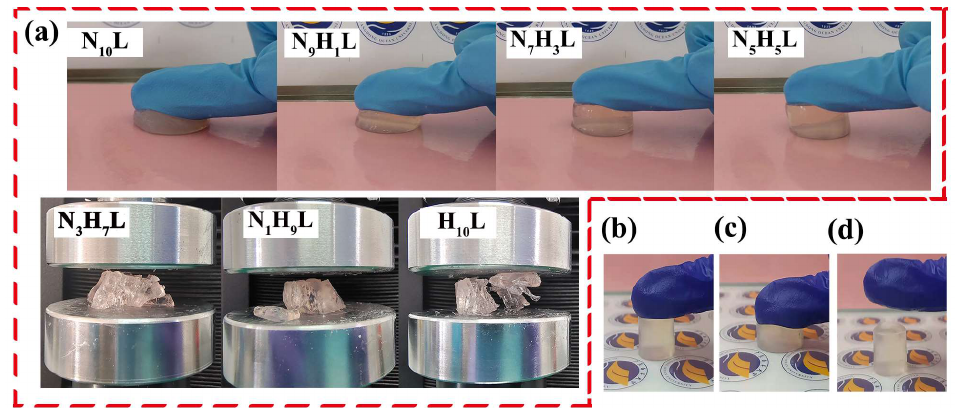
Figure 5. ( a ) Optical images of NC organohydrogel with different monomer molar ratios by pressing at −25 °C; ( b – d ) Optical compression images of N 5 H 5 L at −25 °C after 12 h. From left to right, it is before compression, during the compression and recovered after compression, respectively.